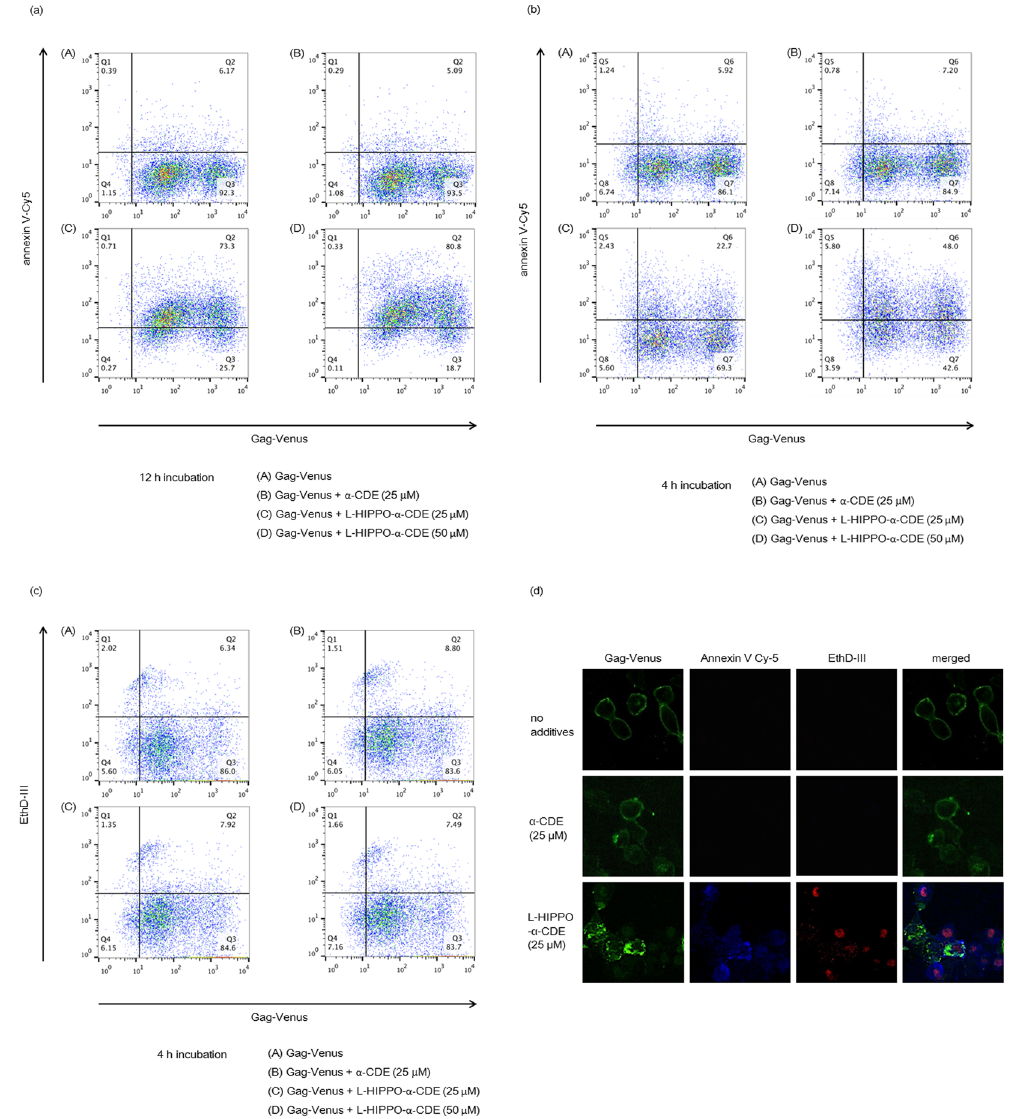
Figure 3. Apoptotic effect of L-HIPPO- α -CDE with HIV-1 protein. ( a ) Apoptotic effect. HeLa cells were transfected with pNL4-3/GagVenus, and after 10 h, complex prepared from L-HIPPO (25 or 50 μ M) and α -CDE (25 μ M) (L-HIPPO- α -CDE) was added. After a further 12 h incubation, FACS analysis using annexin V-Cy5 was performed. ( b ) Apoptotic effect after a shorter incubation time. The same experiment as that in ( a ) was performed using 4 h incubation instead of 12 h incubation. ( c ) Necrotic effect after a shorter incubation time. The same experiment as that in ( b ) was performed using EthD-III instead of annexin V-Cy5. ( d ) Apoptotic effect observed by microscopy. The same experiment as ( a ) using L-HIPPO (25 μ M) and α -CDE (25 μ M) was performed by microscopic observation using annexin V-Cy5 and EthD-III instead of FACS